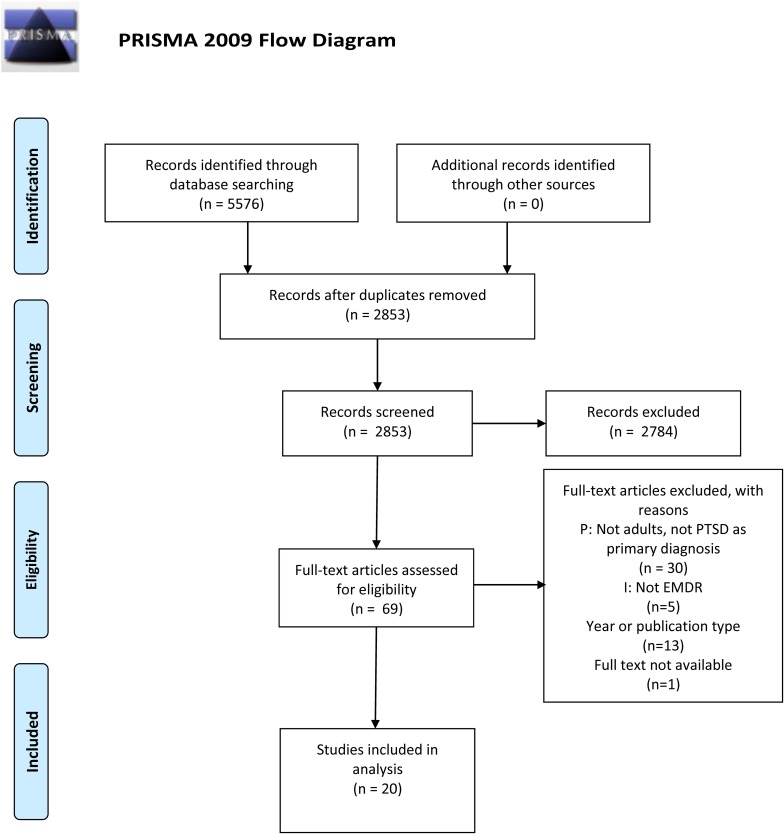
Prisma2009 flow diagram. Adapted from Moher et al. (2009).